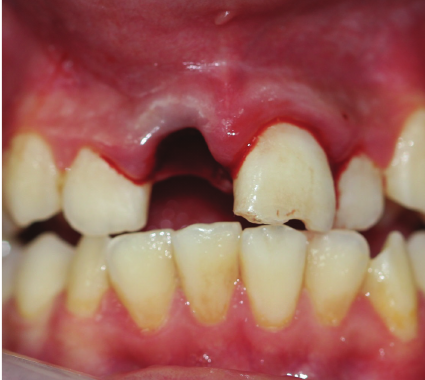
Figure 6: Avulsion of the right upper incisor.